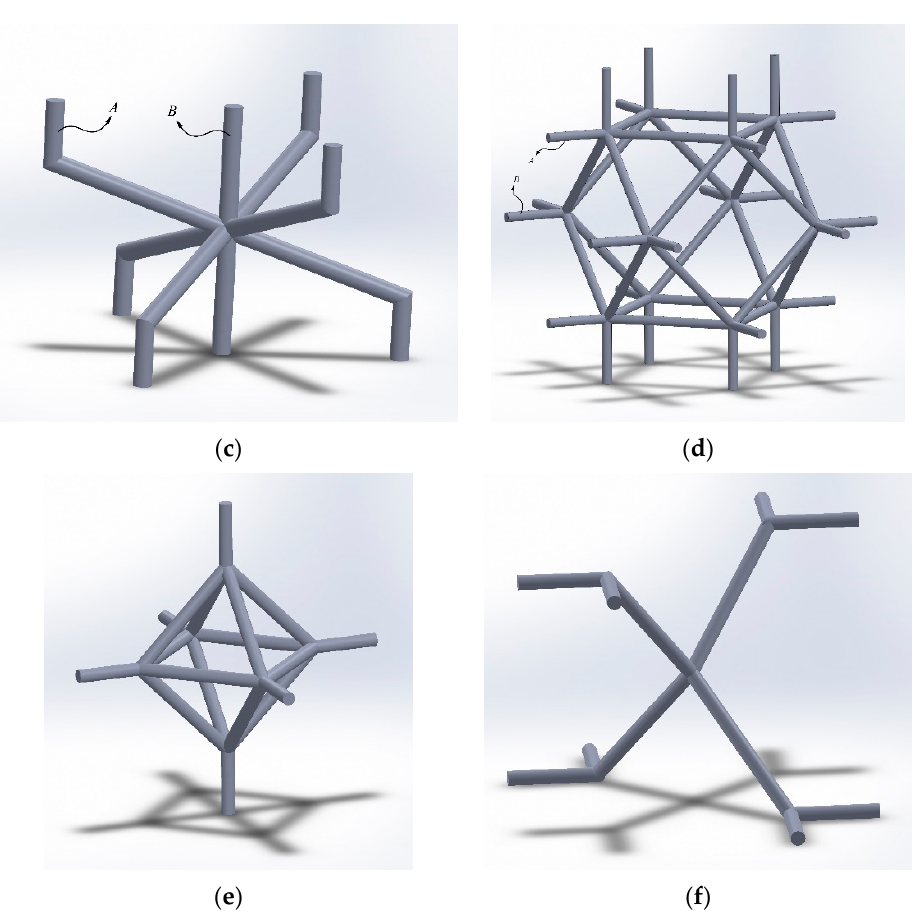
Figure 5. Unit cells used for analytical and numerical analysis: ( a ) BCC, ( b ) diamond, ( c ) hexagonal packing, ( d ) rhombicuboctahedron, ( e ) truncated cube, and ( f ) truncated octahedron. Table 1. Conversion table for converting mechanical properties relationships based on Euler–Bernoulli beam theory to mechanical properties relationships based on Timoshenko beam theory.